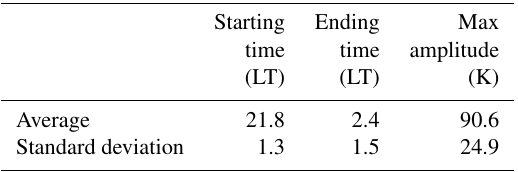
Table 1. Information about the MTM perturbation times (times for the beginning of the first peak and ending of the second) and maxi- mum amplitude for all the